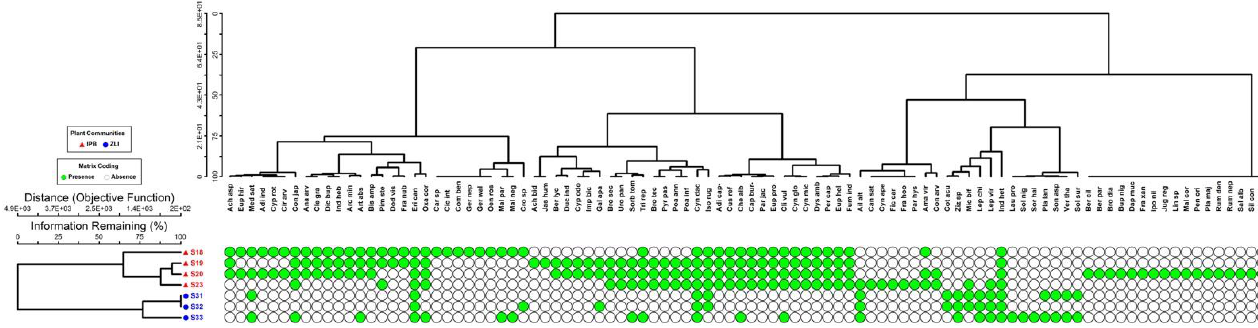
Figure 3. Cluster analysis indicating two different plant communities’ recognition based upon the grouping of seven sam- pling sites and 97 plant species. IPB: Indigofera-Parrotiopsis-Bistorta and ZLQ: Ziziphus-Letopus-Quercus.